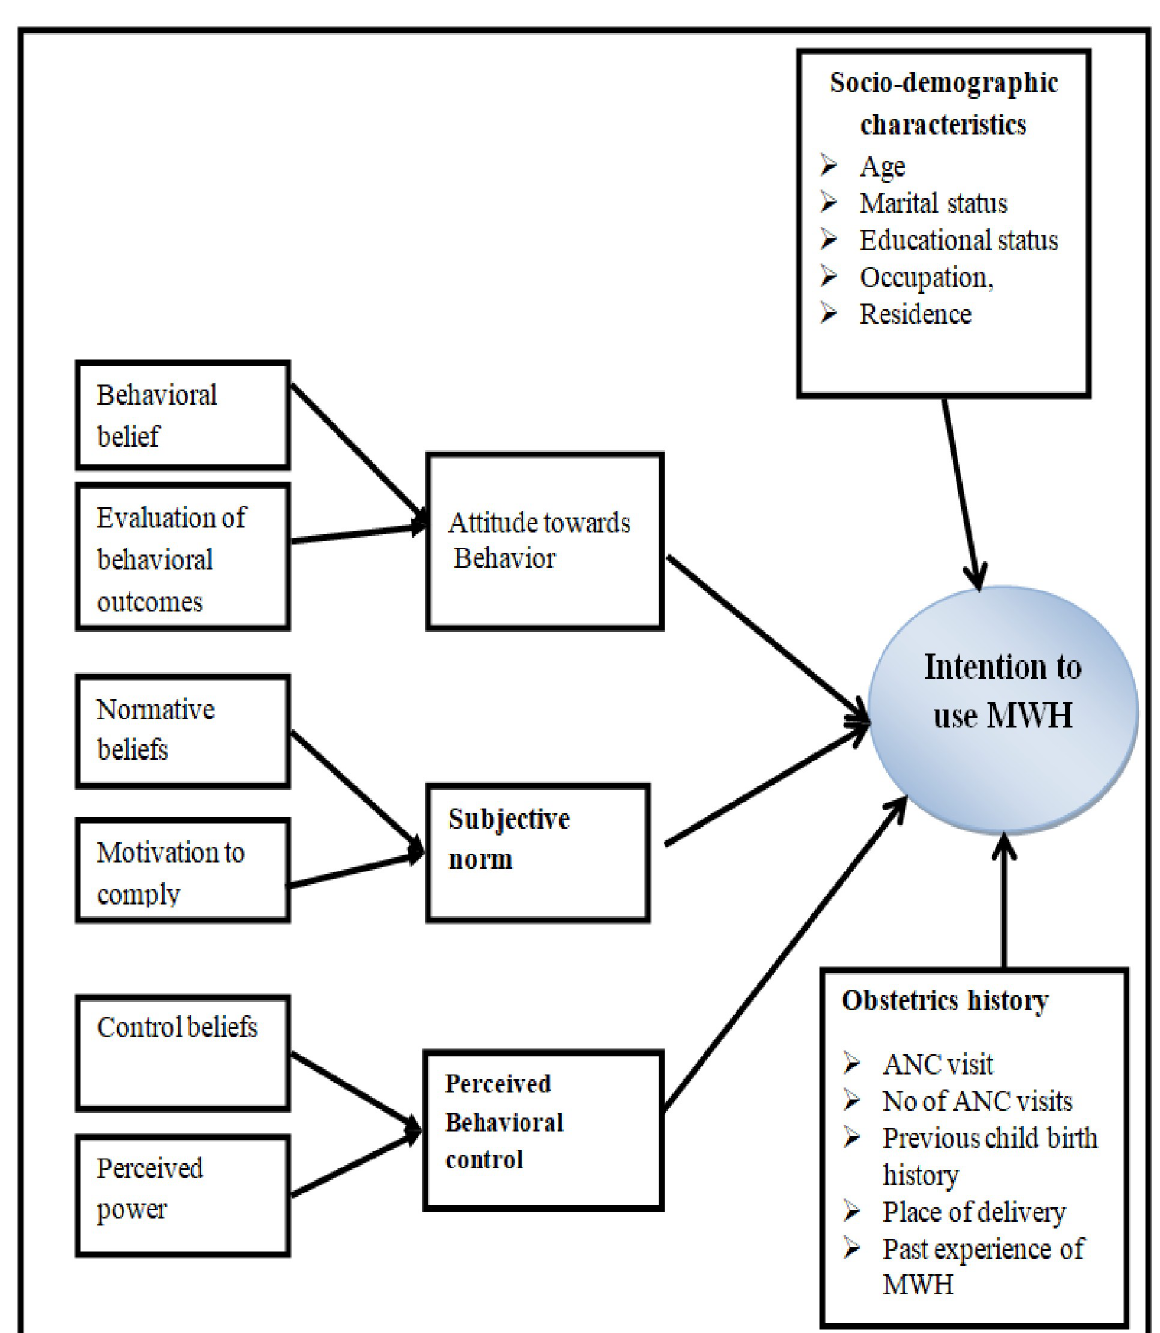
Fig 1. Conceptual framework, which was adapted from the theory of planned behavior, showed factors associated with intention to use maternity waiting home